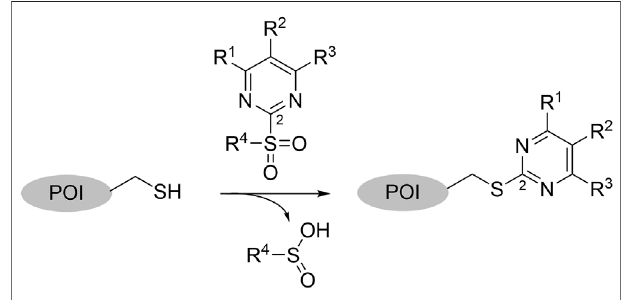
FIGURE 1 | Covalent Reaction of 2-sulfonylpyrimidines. Reaction mechanism of 2-sulfonylpyrimidines with cysteine residues of a respective